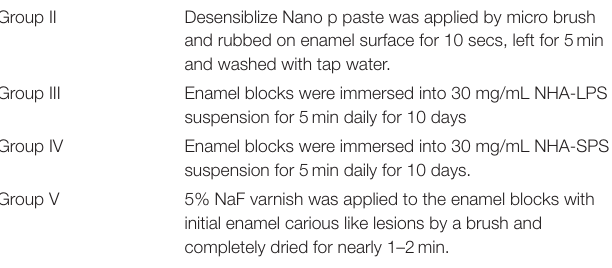
TABLE 2 | The application of the